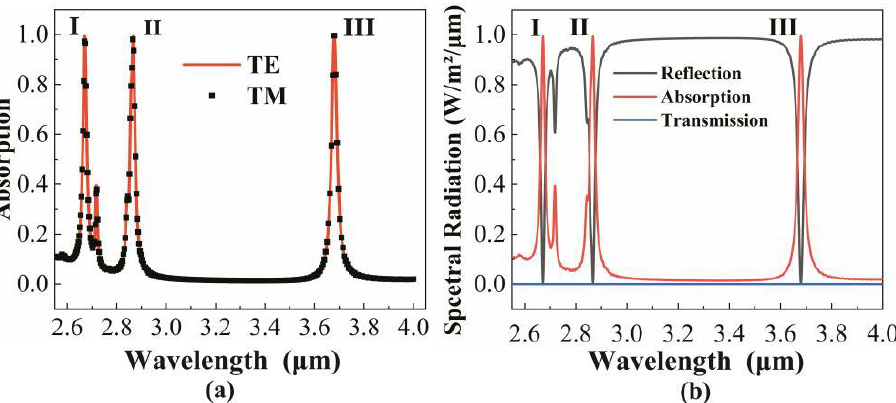
Figure 8. ( a ) Corresponds to the absorption efficiency of resonance wavelength when TE and TM polarized waves vertically incident. ( b ) An absorption, reflection, and transmission diagram of a graphene absorber in the mid-infrared band, and three perfect absorption modes appear (modes I – III).